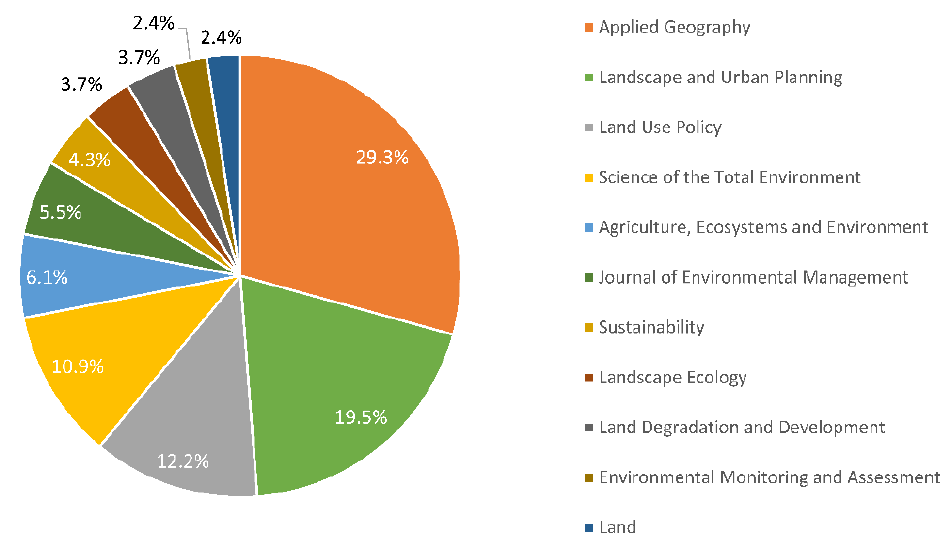
Figure 5. Affiliation discipline of the first author from all papers. Source: own elaboration.